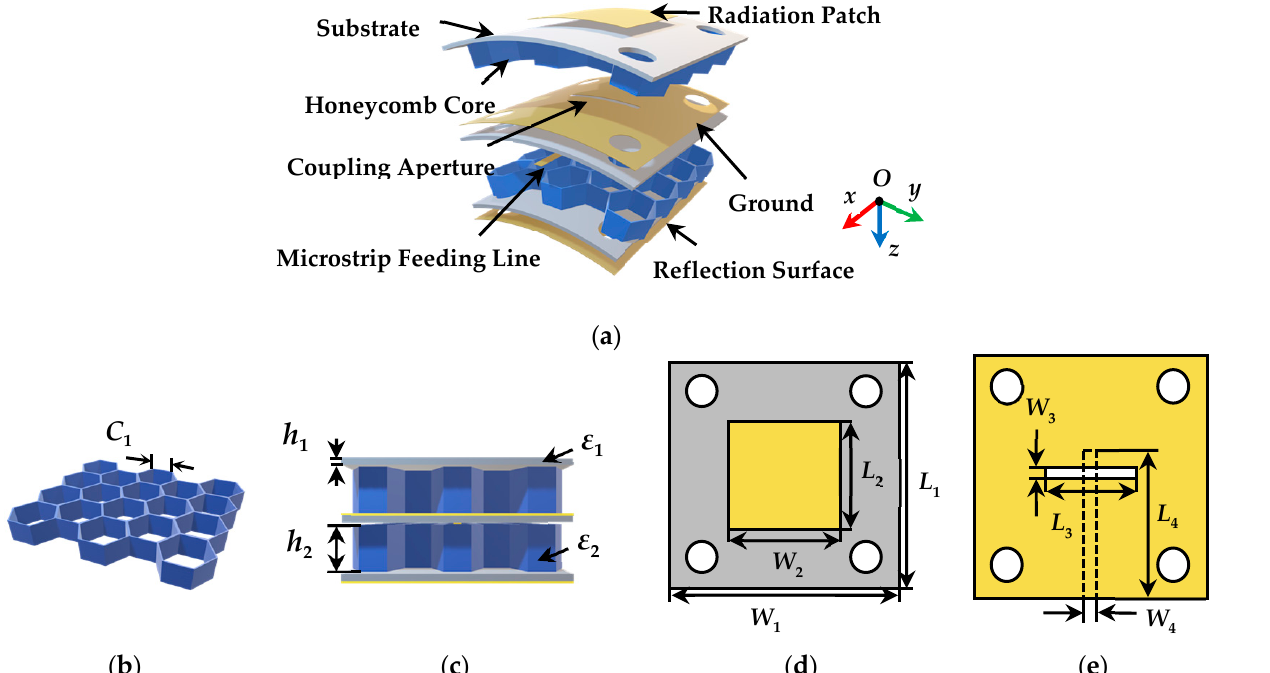
Figure 2. The coordinate geometry and dimensions of the proposed antenna element: ( a ) explosion view of the layered structure, ( b ) honeycomb core structure, ( c ) side view of element, ( d ) top layer with radiation patch, and ( e ) middle layer with the microstrip feeding and ground with coupling aperture.